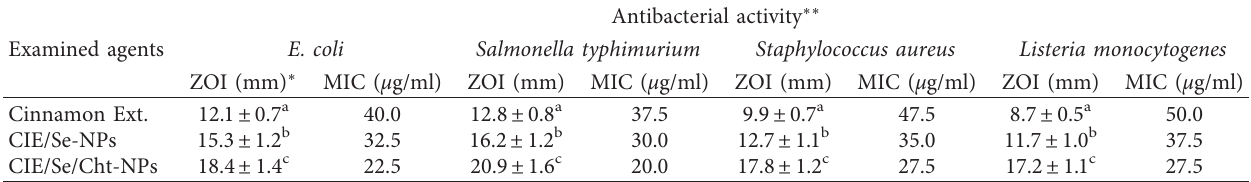
Table 2: Antimicrobial capacities of phycosynthesized Se nanoparticles with cinnamon extract against food-borne bacteria. Examined